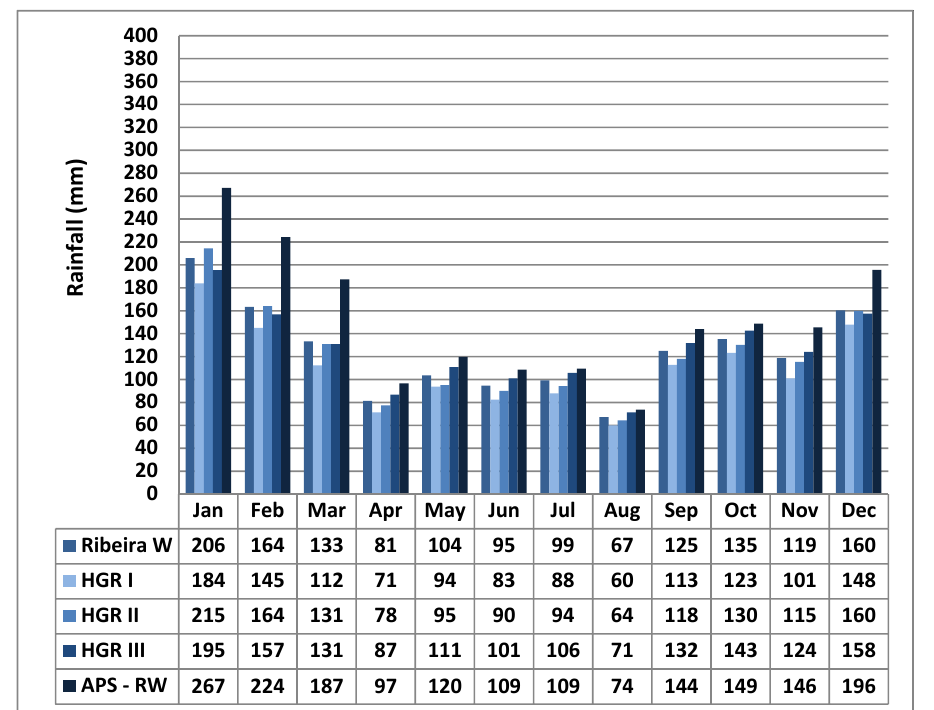
Figure 10. Average monthly rainfall (mm) for the homogeneous groups (HG) and anomalous pluviometric station (APS) in the Ribeira watershed (W), Paraná, Brazil.